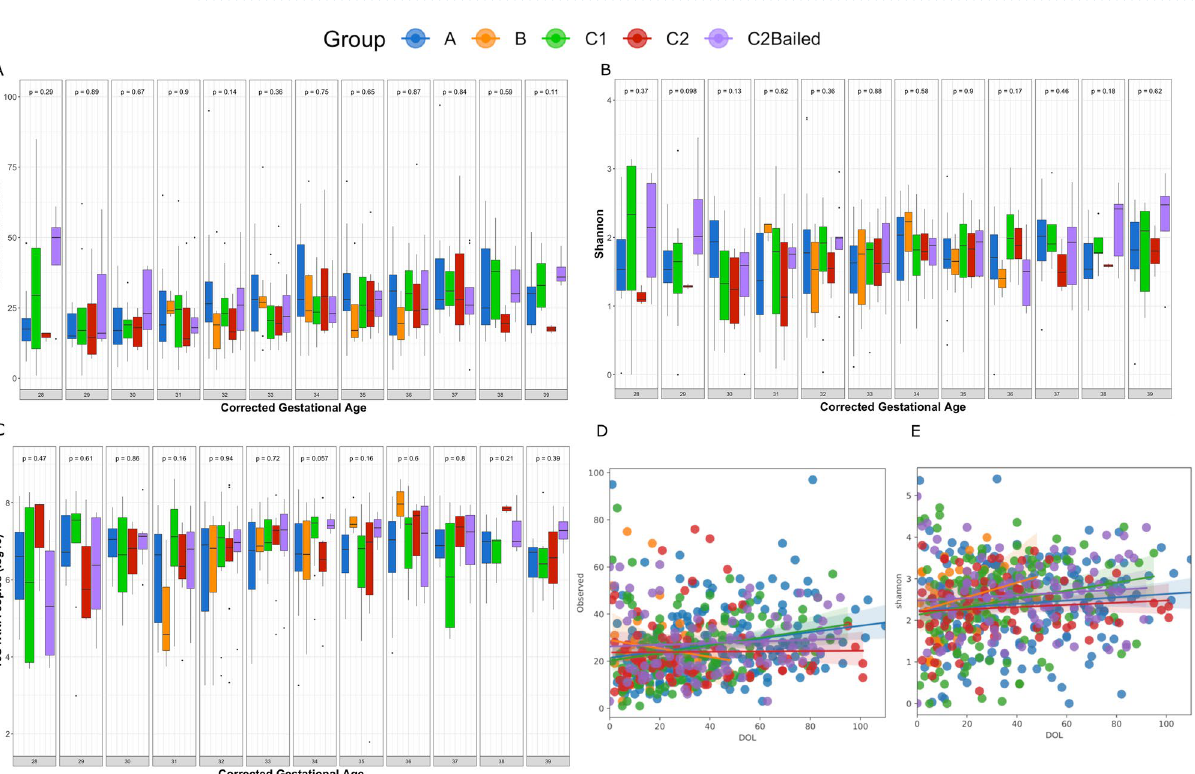
Figure 1. Antibiotic use 48 h after birth does not significantly affect alpha diversity development. Boxplots displaying ( A ) the observed ASV richness ( B ) the Shannon diversity and ( C ) log 10 -transformed copies of 16S rRNA by enrollment group across corrected gestational ages between weeks 28 and 39. P values were calculated at each corrected GA timepoint between enrollment groups using the non-parametric Kruskal–Wallis test. Linear mixed-effects modeling of the ( D ) observed ASV richness and ( E ) Shannon diversity over time between enrollment groups. Time scale on the x-axis is days of life (DOL) for corrected GA weeks 28–39. Greyed areas around each regression line represent 95% confidence intervals upper and lower around the